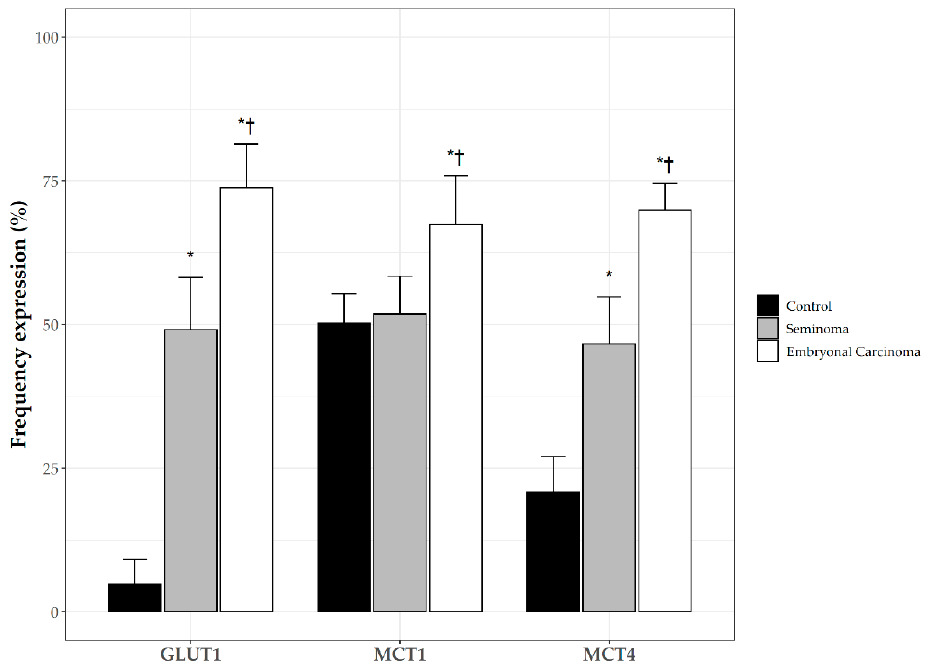
Figure 6. Frequency of plasma membrane expression of Glucose transporter 1 (GLUT1); monocar- boxylate transporters 1 (MCT1), and monocarboxylate transporters 4 (MCT4) in control testis and TGCTs. *: p < 0.05 vs. control; † : p < 0.05 vs. SE.